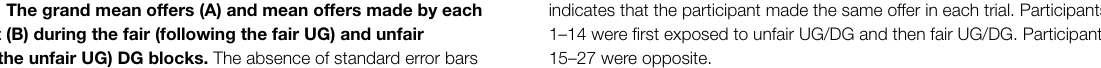
FIGURE 3 | The grand mean offers (A) and mean offers made by each participant (B) during the fair (following the fair UG) and unfair (following the unfair UG) DG blocks. The absence of standard error bars